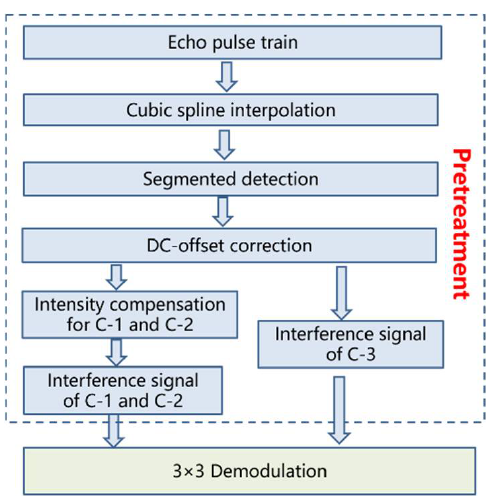
Figure 2. Flowchart of pretreatment method.